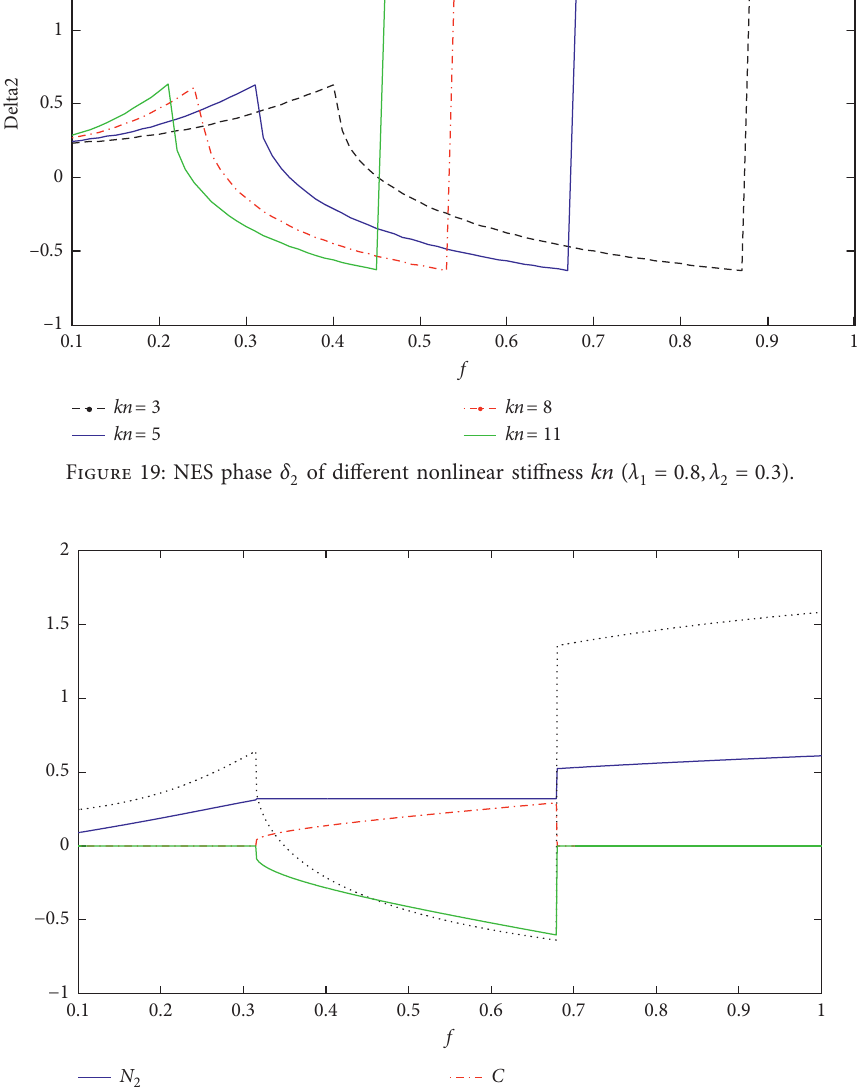
� 0 . 8 , λ � 0 . 3 ,kn � 1 2